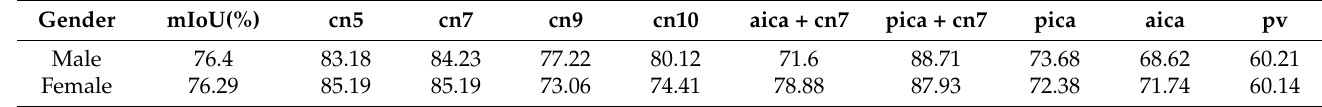
Table 10. Accuracy comparison for gender on the MVD test